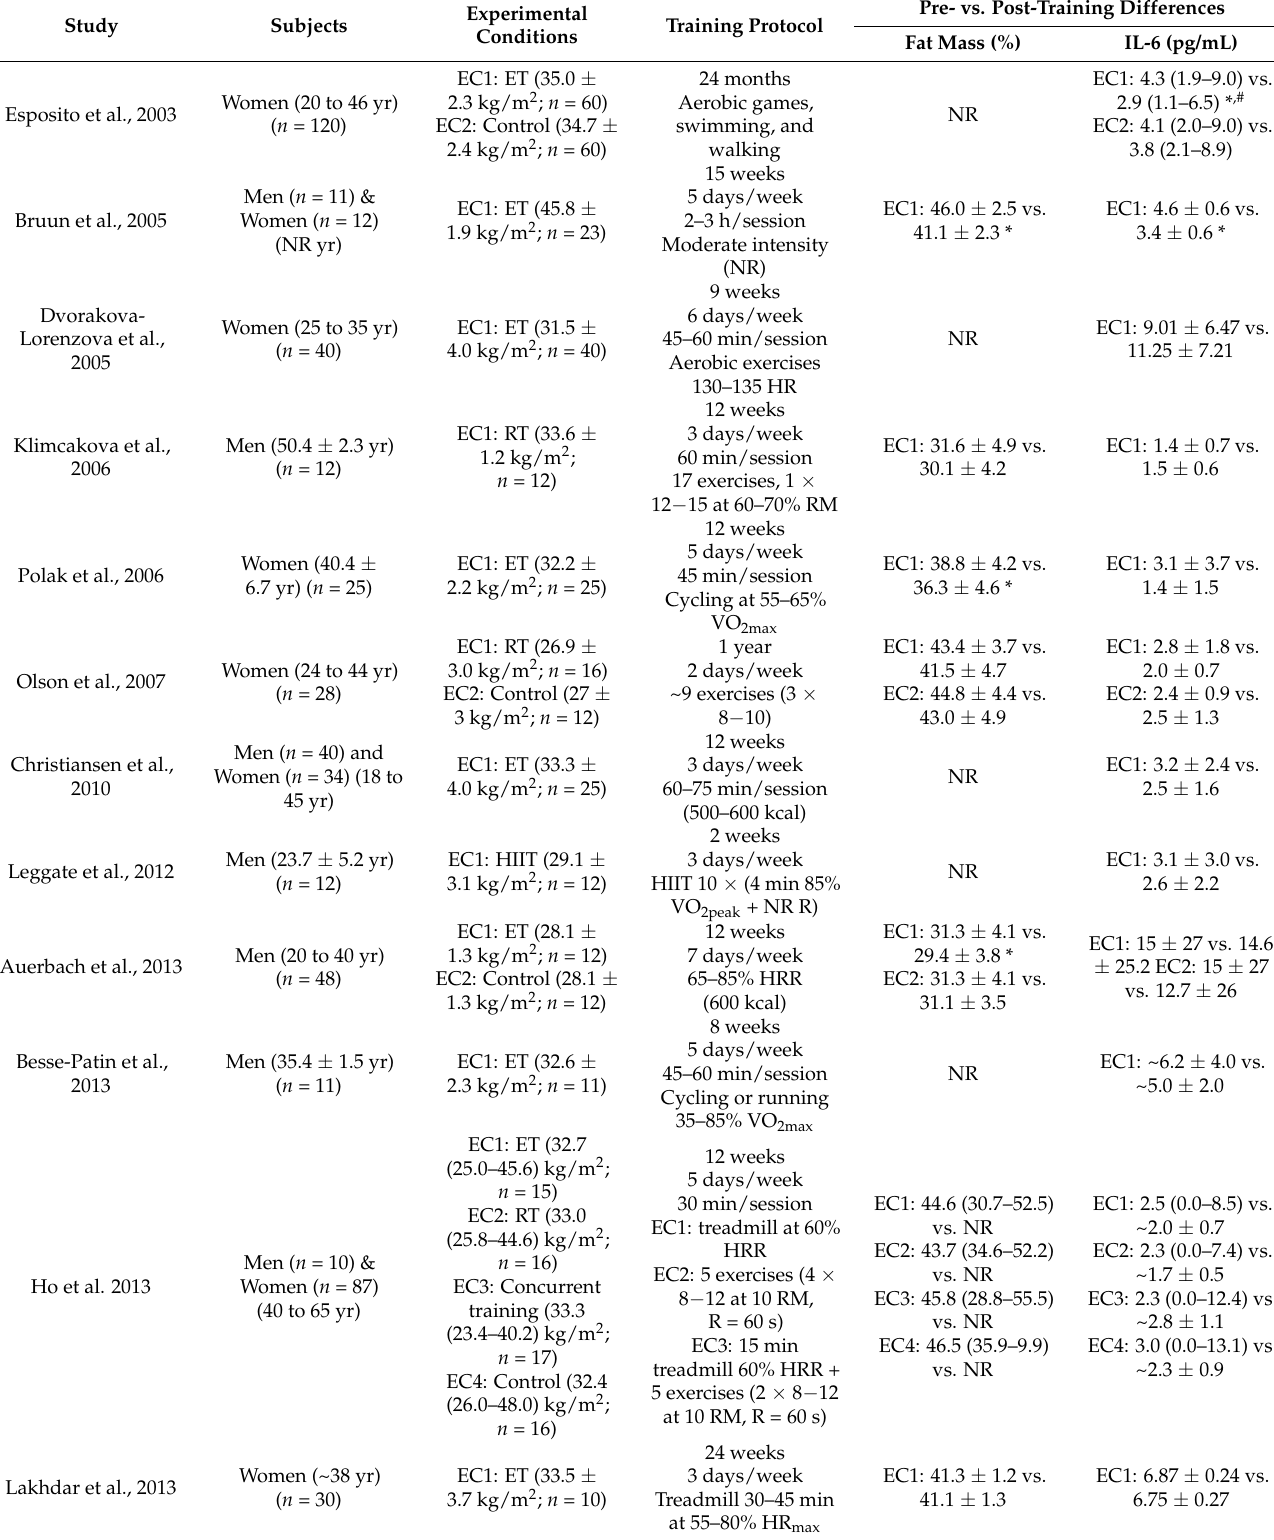
Table 2. Effects of training on the circulating concentrations of IL-6 in sedentary adults with overweight or obesity.